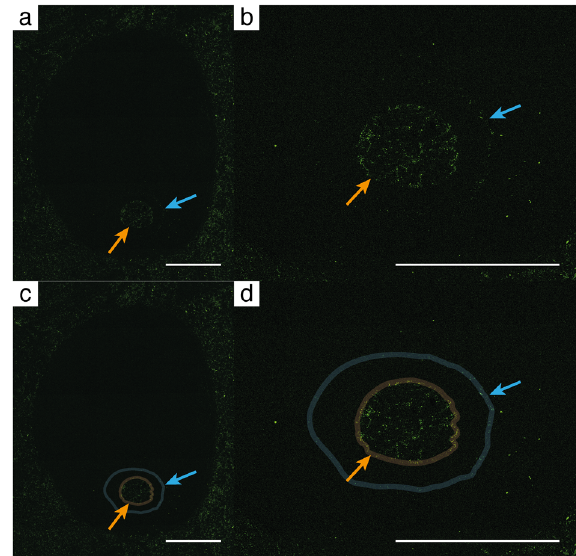
Fig. 3 SEM-EDX image showing the distribution of phosphor in NFM F-2776. a , c Phosphor enrichment reveals the position of the inner (orange arrow) and outer wall (blue arrow) of the connecting ring. b , d Detailed view of a and c . Scale bar is 1